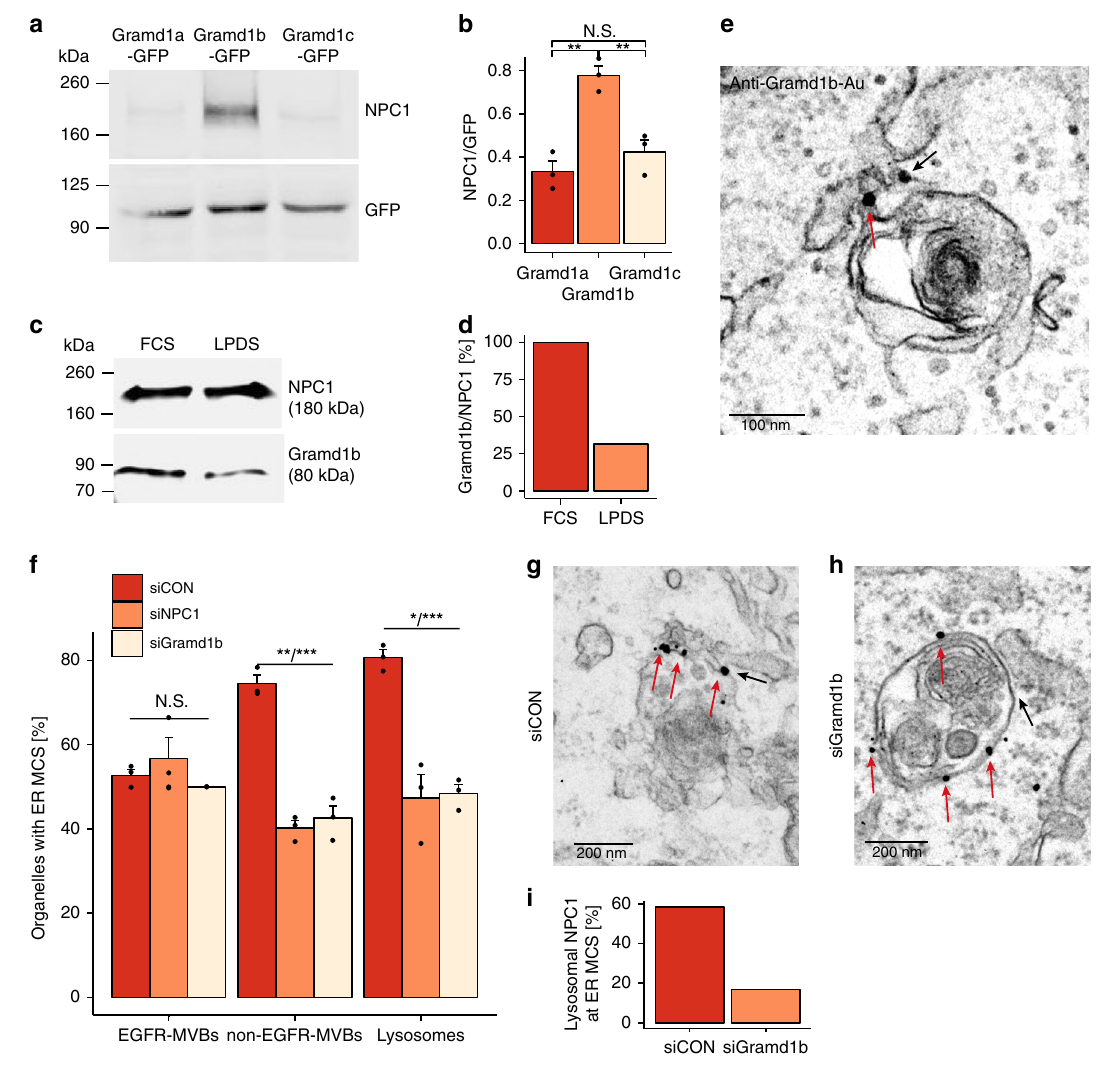
Fig. 2 NPC1 interacts with the ER-localised sterol transport protein Gramd1b at MCSs. a GFP immunoprecipitates from HeLa cells transfected with Gramd1a-c GFP plasmids were immunoblotted with anti-NPC1 and GFP antibodies. b Quanti fi cation of the ratio of NPC to GFP present in a , represented as a mean of three independent experiments. Welch two sample t -tests were performed between all conditions (Gramd1a/Gramd1b: ** P = 0.00275, Gramd1b/Gramd1c: ** P = 0.00836, Gramd1a/Gramd1c: N.S. P = 0.2835). c NPC1 immunoprecipitates from HeLa cells cultured in medium containing 10% FCS or LPDS for 18 h were immunoblotted with anti-Gramd1b antibody. d Quanti fi cation of the amount of Gramd1b as a percentage of NPC1 present in